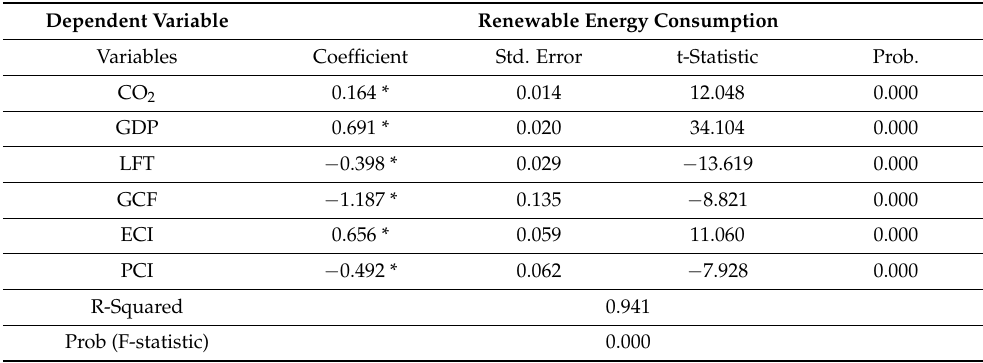
Table 5. Panel regression results for the fixed-effects